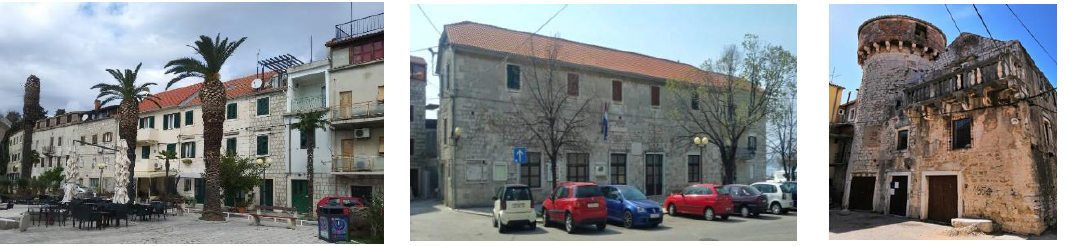
Figure 3. Buildings in the historical